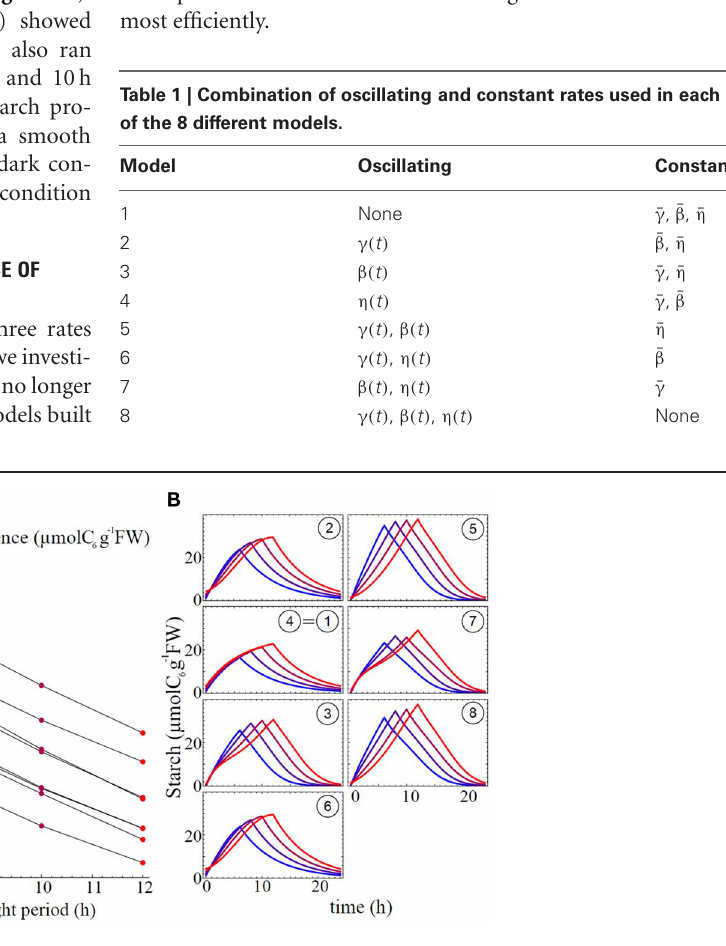
color code as in (A) . Circled numbers stand for the model number and are ordered following ranking from (A) in 6h/18h L/D cycle, better models being those with lower